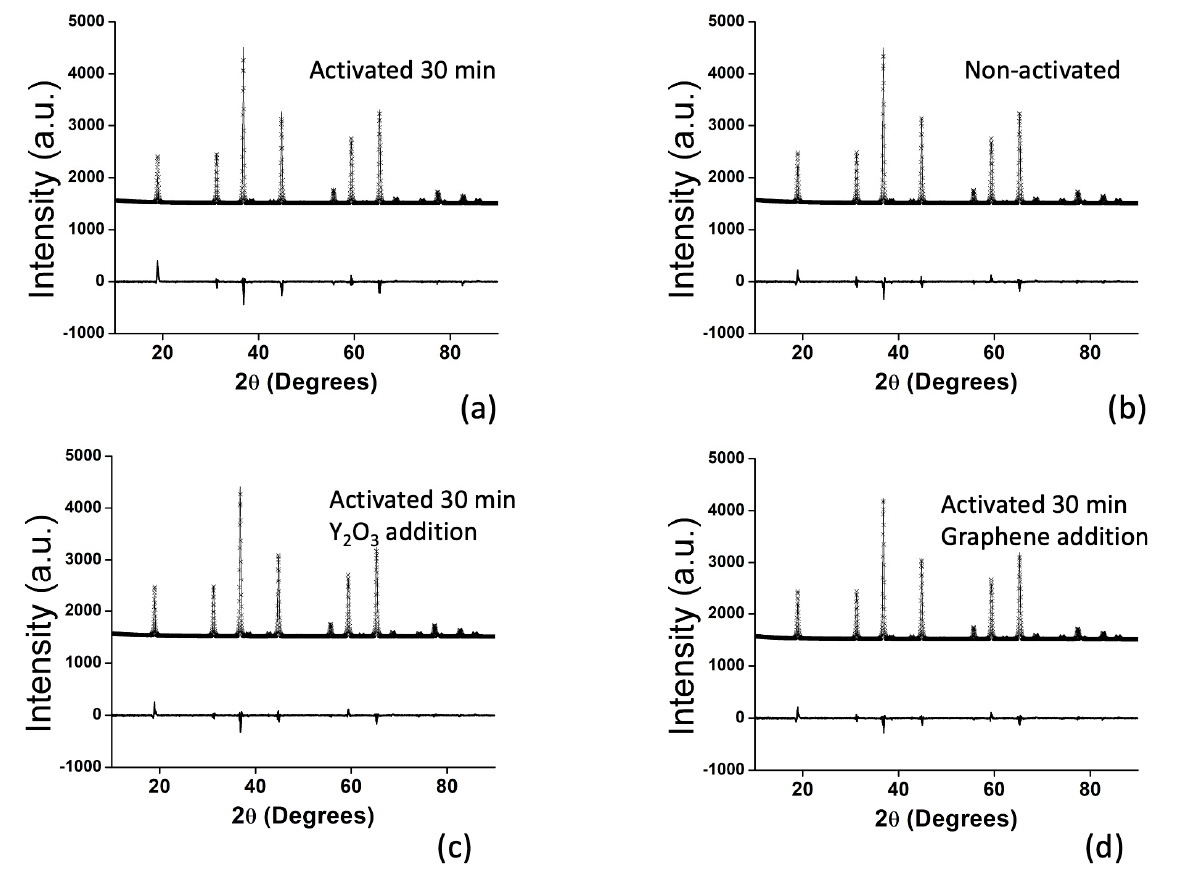
Figure 2. XRPD patterns and Rietveld fits of the sintered specimens: ( a ) HP1, ( b ) HP2, ( c ) HP3, and ( d ) HP4.